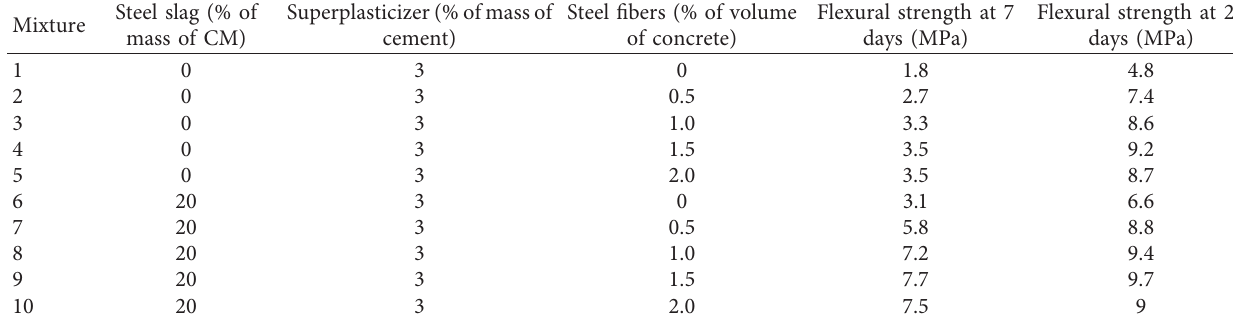
Table 4: Flexural strength results at 7 and 28 days.